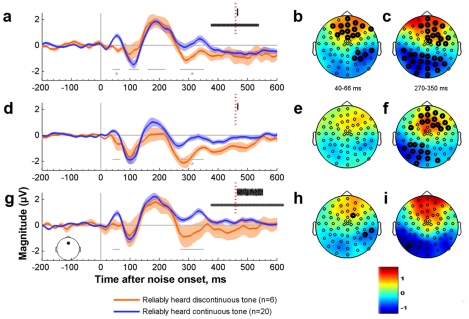
ERP aligned to the onset of noise bursts:
a,b,c, 50-ms noise burst presented together with the tone; d,e,f 50-ms noise burst alone. g,h,i 1000-ms noises together with the tone (see also insets in panels a,d,g). A,d,g: Lines are group means and shaded areas are standard errors. Horizontal gray lines denote time windows of interest. Gray asterisks next to them indicate the significant correlation between magnitude and performance (test was done using all 35 participants, and not only the two groups of participants depicted here for clarity). Panels b,e,h refer to P50 component (40–66 ms after sound onset). Panels c,f,i refer to N270–350 component. In b,c,e,f,h,i color denotes the scalp distribution of the potential differences between participants that reliably heard the continuous tone as continuous and those that reliably heard it as discontinuous. Electrodes with nominally significant correlations between performance and voltage in all subjects (p<0.05, uncorrected) are highlighted with bold circles.